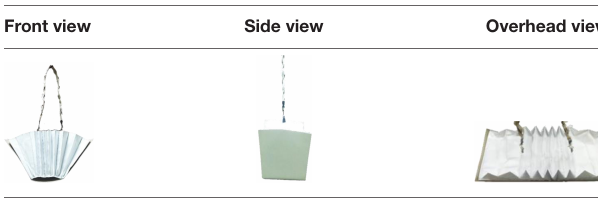
TABLE 3 | Student A’s “winter flowers” paper bag